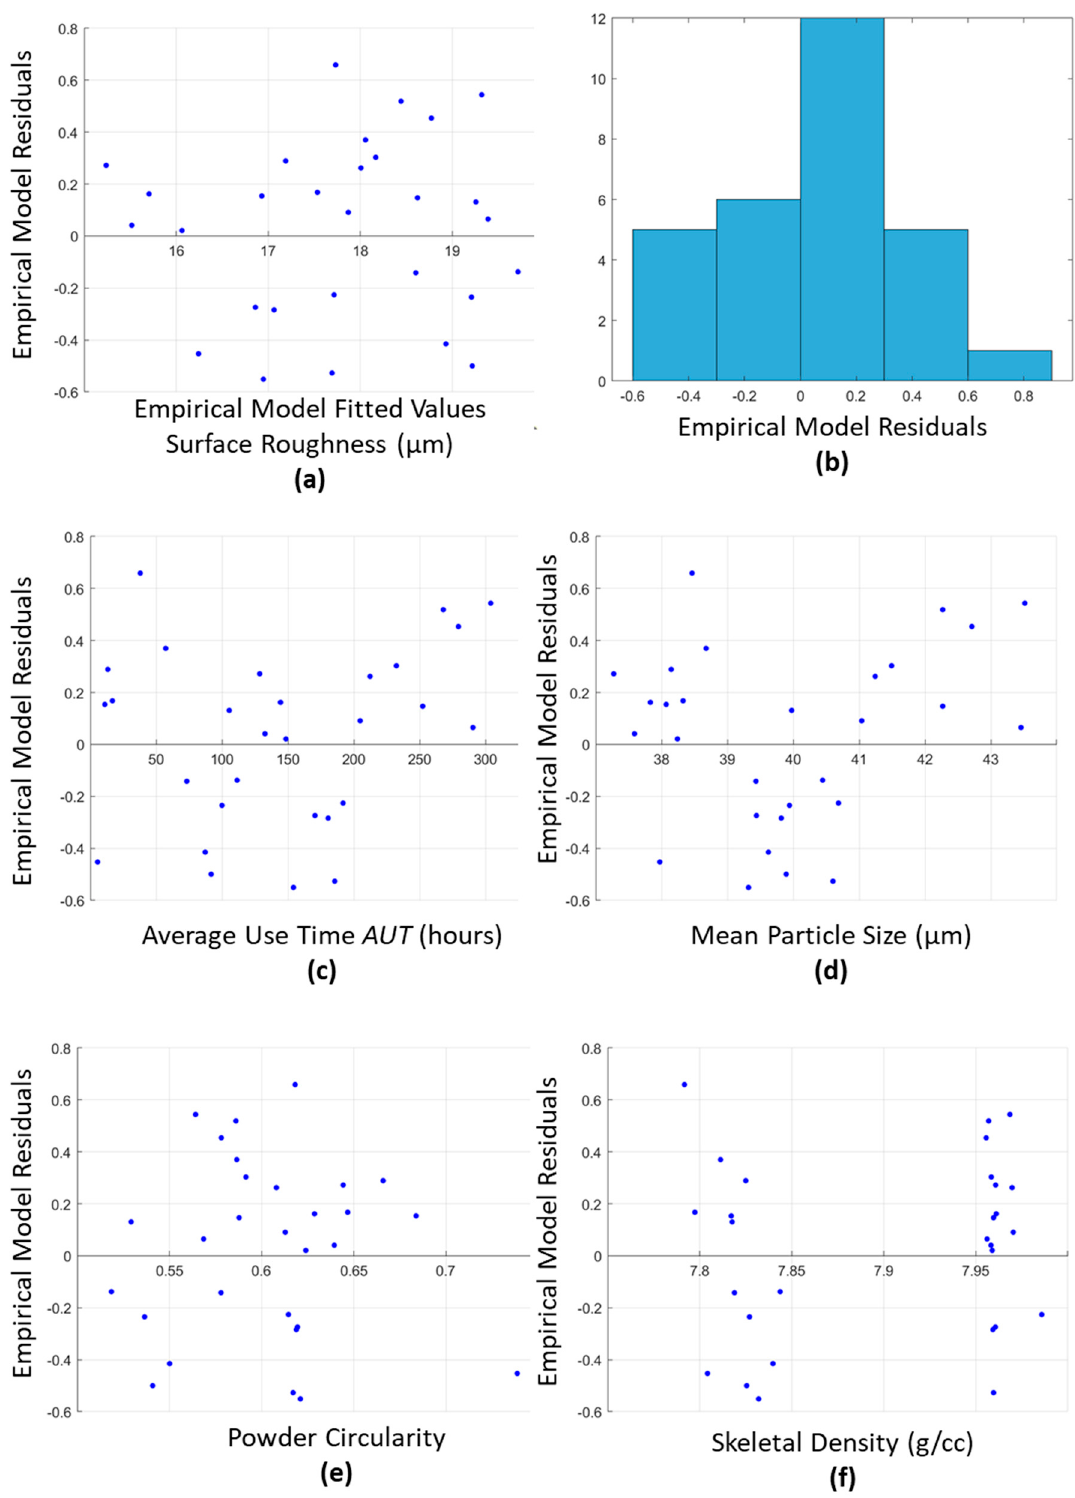
Figure 9. Surface Roughness MLR Model results based on the initial assumption tests, required to determine the validity of the developed model.